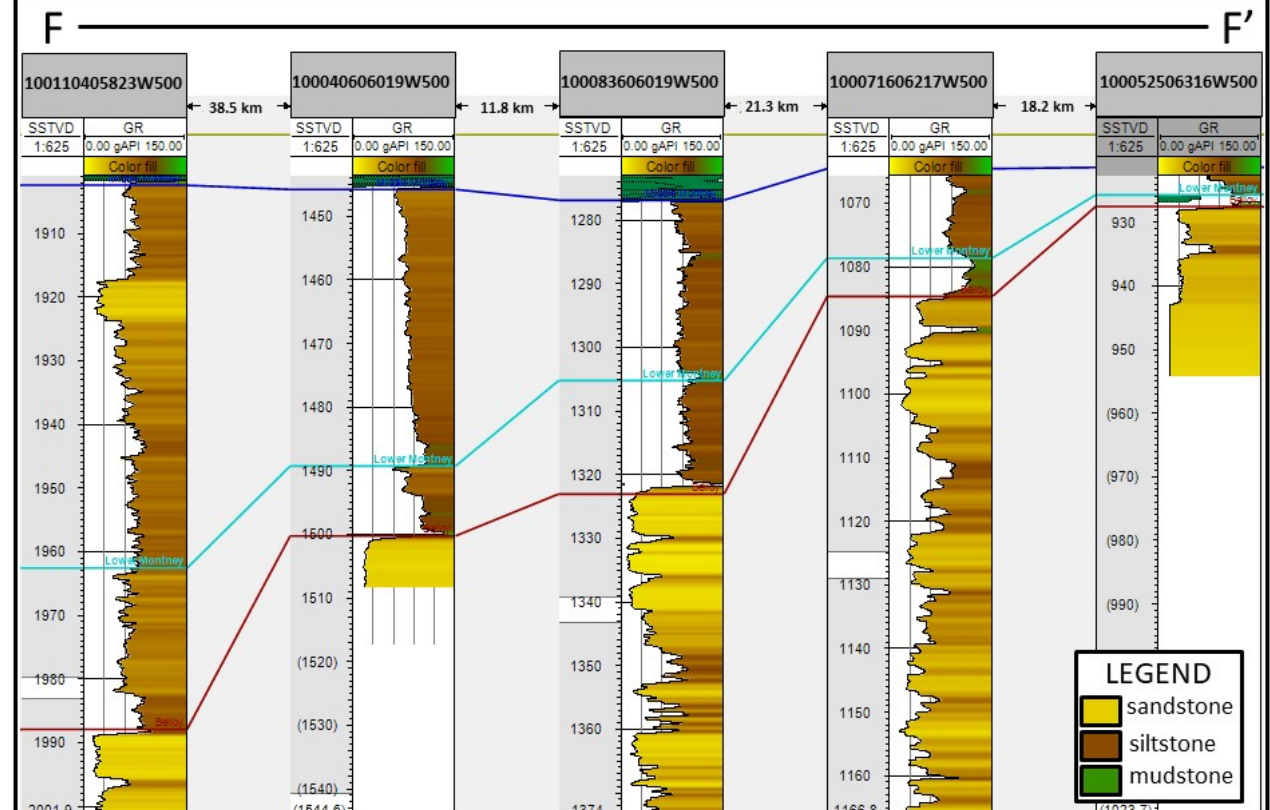
Figure 33. NE-SW cross-section along the depositional dip near the Fox Creek area. See Figure 24 for the location of the cross-section F–F ′ . The Upper Montney Top is the brownish yellow line, the Middle Montney Top is the dark blue line, the Lower Montney Top is light bluish green line, and the base of the Montney at the Belloy Top is the dark red line. The Montney formation dramatically thins to the NE into Alberta. This cross-section cuts through the higher gas dryness area of Fox Creek and the sandier facies at a depth of 1920 m in 100110405823W500, potentially acting as a conduit for drier gas migrating from a downdip.